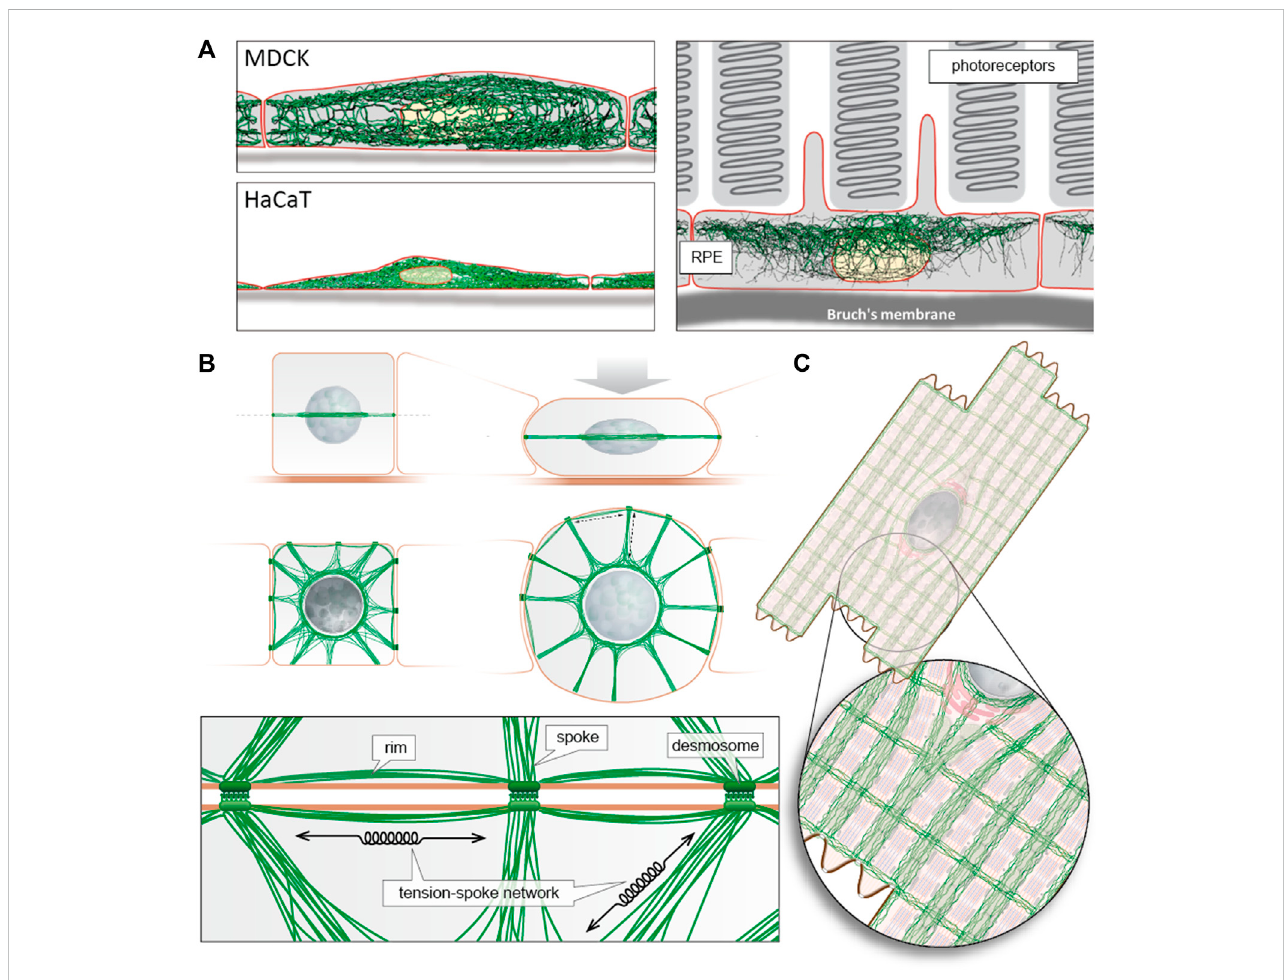
FIGURE 1 Intermediate fi lament architecture is cell type speci fi c to support tissuemechanics and function. (A) The digital reconstructions of intermediate fi lament networks that are superimposed on schematic drawings of the corresponding cells are taken from Windoffer et al. (2022). They were derived from 3D recordingsof fl uorescently labelledkeratinsinpolarizedcanine MDCKcells,humanimmortalizedepidermalHaCaTkeratinocytesandmurineretinal pigment epithelial cells in situ . Note the different network distributions ranging from apical enrichment (RPE) to apical and basal enrichment (MDCK) and pan cytoplasmic (HaCaT). (B) The modi fi ed scheme from Quinlan et al. (2017) highlights the circumferential rim and radial spokes arrangement of keratin intermediate fi laments connecting the network to the perinuclear cage and adjacent cells through desmosomes. The resulting transcellular tension-spoke system provides mechanical resilience. (C) Schematic representation of desmin intermediate fi lament architecture in cardiomyocytes providing de fi ned subcellular spaces for the ordered contractile apparatus, mitochondria, the nucleus and attachment sites to neighbouring cardiomyocytes and the extracellular matrix (adapted from (Behrendt, 1977; Tokuyasu et al. 1983; Wang and Ramirez-Mitchell,